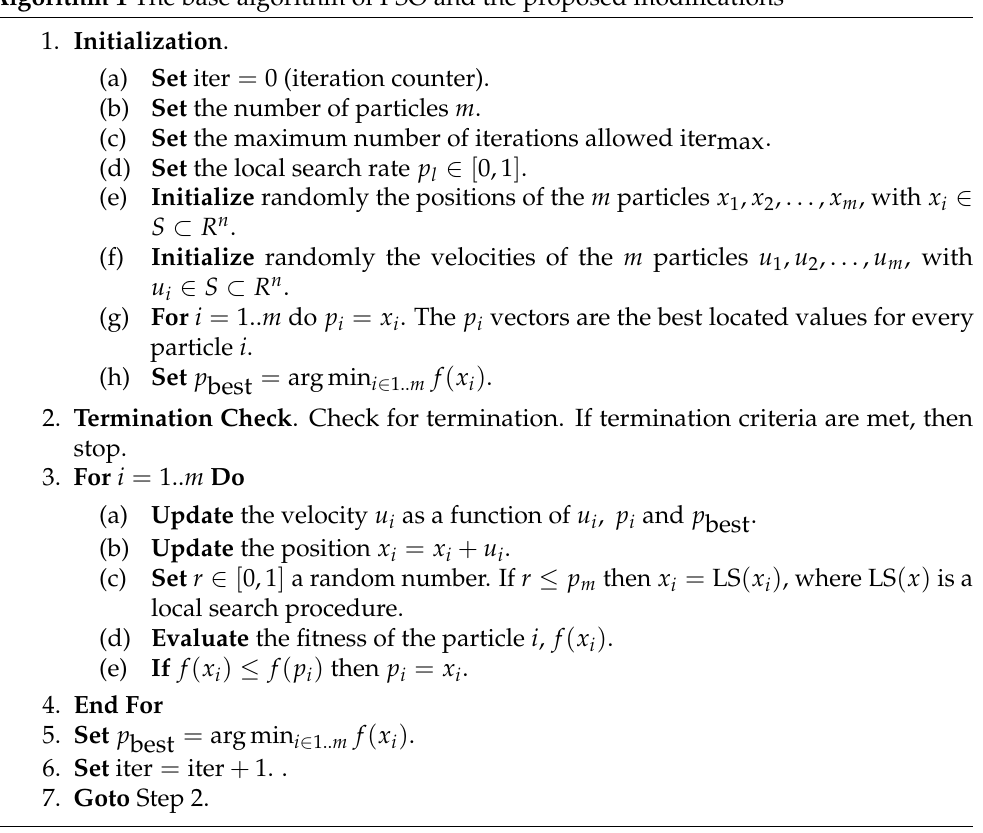
Algorithm 1 The base algorithm of PSO and the proposed